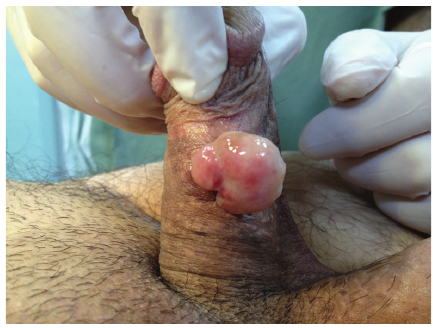
Figure 1: The polypoid appearance of pyogenic granuloma.